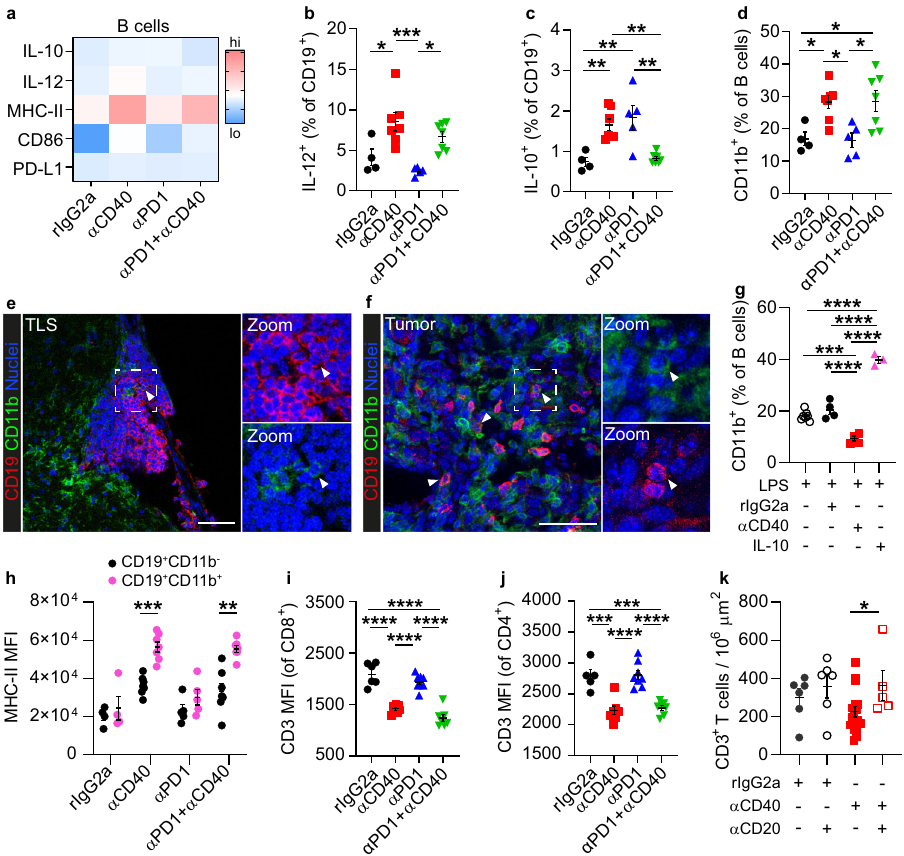
Fig. 6 Systemic delivery of α CD40 was associated with a CD11b + regulatory phenotype of B cells. All panels besides panel g show data from GL261 tumor-bearing mice. a Heatmap showing the expression levels of activation and immunosuppression markers on B cells in the brain, in the indicated treatment groups. b , c Quanti fi cation of b IL-12 + and c IL-10 + cells as a percentage of B cells in the brain, in the indicated treatment groups. b p = 0.0175, p = 0.0005, p = 0.0140. c p = 0.0081, p = 0.0031, p (rIgG2a vs. α CD40) ( α CD40 vs. α PD1) ( α PD1 vs. α PD1 + α CD40) (rIgG2a vs. α CD40) (rIgG2a vs. α PD1) ( α CD40 vs. α PD1 = 0.0047, p = 0.0018. d CD11b + cells as a percentage of B cells in the brain, in the indicated treatment groups. p + α CD40) ( α PD1 vs. α PD1 + α CD40) (rIgG2a vs. α CD40) = 0.0453; p = 0.0391¸ p = 0.0236; p = 0.0201. a – d n (rIgG2a) = 4 mice, n ( α CD40) = 7 mice, n (rIgG2a vs. α PD1 + α CD40) ( α CD40 vs. α PD1) ( α PD1 vs. α PD1 + α CD40) ( α PD1) = 5 mice, n ( α PD1 + α CD40) = 7 mice. b – d One-way ANOVA with Tukey ’ s correction for multiple comparisons. e , f Immuno fl uorescent stainings showing CD11b + B cells e in the TLS and f in the tumor area. Scale bars: 50 µ m. g Quanti fi cation of CD11b + cells as a percentage of wt murine splenic B cells after in vitro stimulation with the indicated agents. n (LPS) = 7 mice, n (LPS + rIgG2a) = 4 mice, n (LPS + α CD40) = 4 mice, n (LPS + IL-10) = 3 mice. One way ANOVA with Tukey ’ s correction for multiple comparisons. p (LPS vs. LPS + α CD40) = 0.0002, all other indicated p -values are p < 0.0001. h Mean fl uorescence intensity (MFI) of MHC-II on CD11b + vs CD11b − B cells in the brain, in the indicated treatment groups. n (rIgG2a) = 4 mice, n ( α CD40) = 7 mice, n ( α PD1) = 5 mice, n ( α PD1 + α CD40) = 7 mice. p ( α CD40) = 0.0002; p ( α PD1 + α CD40) = 0.0017. Multiple t -test with Sidak-Bonferroni correction. i , j MFI of CD3 on i CD8 + and j CD4 + T cells in the indicated treatment groups. One-way ANOVA with Tukey ’ s correction for multiple comparisons. i n (rIgG2a) = 6 mice, n ( α CD40)&( α PD1 + α CD40) = 7 mice, n ( α PD1) = 8 mice. All indicated p -values are p < 0.0001. j n (rIgG2a) = 5 mice, n ( α CD40)&( α PD1 + α CD40) = 7 mice, n ( α PD1) = 8 mice. p = 0.0002, p = 0.0004. All indicated p -values are p < 0.0001. k Quanti fi cation of the (rIgG2a vs. α CD40) (rIgG2a vs. α PD1 + α CD40) number of CD3 + T cells in the tumor area in rIgG2a- or α CD40-treated mice with or without B cell depletion. n (rIgG2a)&(rIgG2a + α CD20) = 6 mice, n ( α CD40) = 17 mice, n ( α CD40 + α CD20) = 5 mice. p ( α CD40 vs. α CD40-B) = 0.0442. One-way ANOVA with Tukey ’ s correction for multiple comparisons. b – d , i , j Black circle indicates rat IgG2a (rIgG2a), red square indicates agonistic CD40 antibodies ( α CD40), blue triangle (pointing up) indicates PD1 blocking antibodies ( α PD1), green triangle (pointing down) indicates α PD1 + α CD40. g Empty circle indicates lipopolysaccharide (LPS), black circle indicates LPS + rat IgG2a (rIgG2a), red square indicates LPS + agonistic CD40 antibodies ( α CD40), pink triangle (pointing up) indicates LPS + interleukin 10 (IL-10). h Black circle indicates CD19 + CD11b − B cells, pink circle indicated CD19 + CD11b + . k Black circle indicates rIgG2a, empty circle indicates rIgG2a + α CD20, red square indicates α CD40, empty square indicates α CD40 + α CD20. For all graphs in this fi gure, * p < 0.05, ** p < 0.01, *** p <0.001, **** p < 0.0001. Bars: mean ± SEM. Source data are provided as a Source Data fi